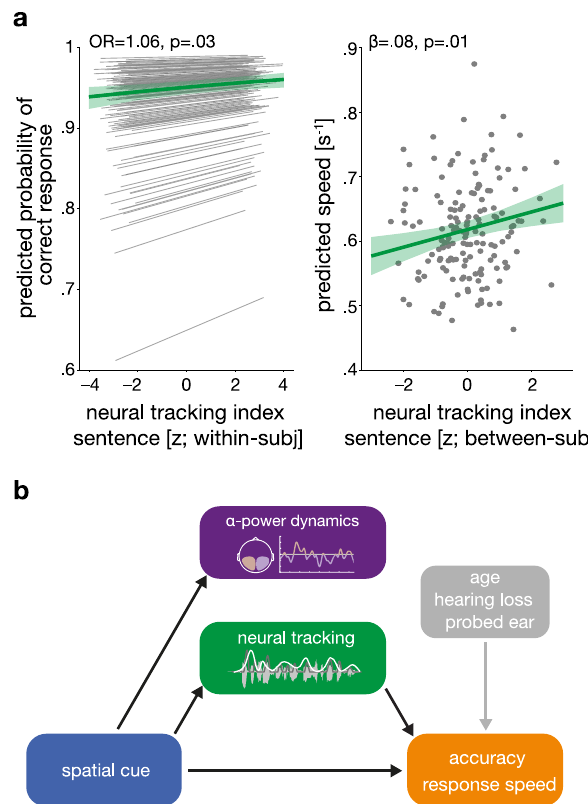
Fig. 6 Neural speech tracking predicts listening behaviour. a Model predictions for the effect of neural tracking on behaviour for N = 155 participants. Left panel shows the predicted group-level fi xed effect (green line ± 95% CI) of trial-to-trial variation in neural tracking on accuracy. Grey thin lines indicate estimated subject-speci fi c slopes. Right panel shows the predicted group-level fi xed effect of neural tracking at the between-subject level on response speed (green line ± 95% CI). Grey dots indicate subject- level model predictions. OR: odds ratio, β : slope parameter estimate from the corresponding general linear mixed-effects model, two-sided Wald test (FDR-corrected). b Summary of results. Black arrows highlight statistically signi fi cant effects from (generalized) single-trial linear mixed-effects modelling. Grey arrow shows the effect of additionally modelled in fl uences. Notably, changes in age and hearing loss did not modulate the fi delity of the two key neural measures. Source data are provided as a Source Data fi